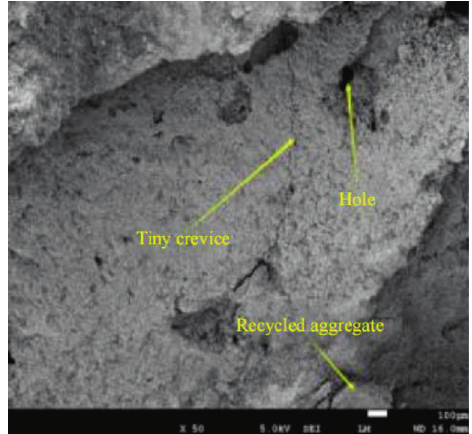
Figure 23: Cement-stabilized pure recycled aggregate.